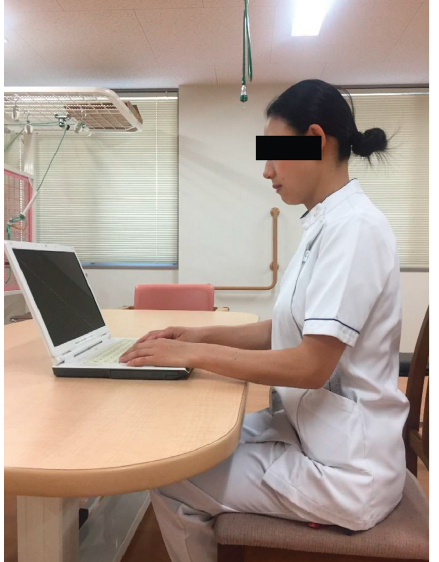
Figure 1: Experimental setting. Participants sat in front of a laptop computer and were asked to put their right and left index fingers on the “M” and “Z” keys, respectively. They were asked to maintain their position, gaze at the screen, and maintain their posture during testing. (Figure 2). Left and right photographic images were mirror images of each other. Photographic images of hands and feet were taken from the dorsal surface. All stimuli were pre- sented at six different degrees of orientations (0 ° , 60 ° , 120 ° , 180 ° , 240 ° , and 300 ° ) for both sides. Photographic images were rotated in a clockwise direction from 0 ° .